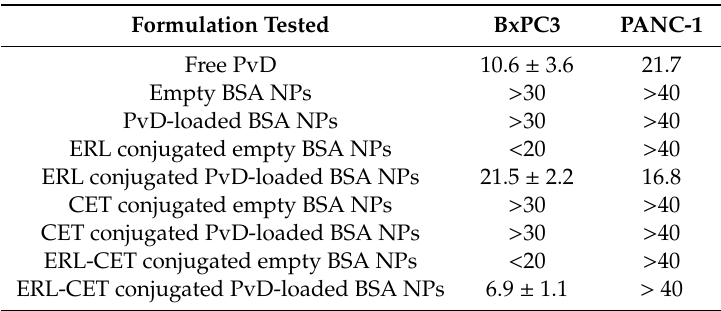
Table 3. Antiproliferative effect (IC 50 ) of PvD in free form or nanoformulated in two human pancreatic adenocarcinoma cell lines (BXPC3 and PANC-1).